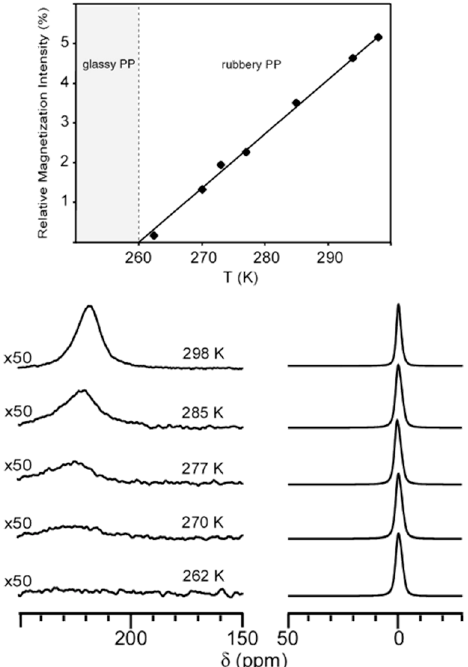
Figure 3. Continuous flow hyperpolarized 129 Xe NMR spectra of polypropylene (PP) particles. At the top, the relative intensity of the dissolved xenon signal is reported as a function of temperature. Reprinted with permission from reference [81]. Copyright 2006 American Chemical Society.